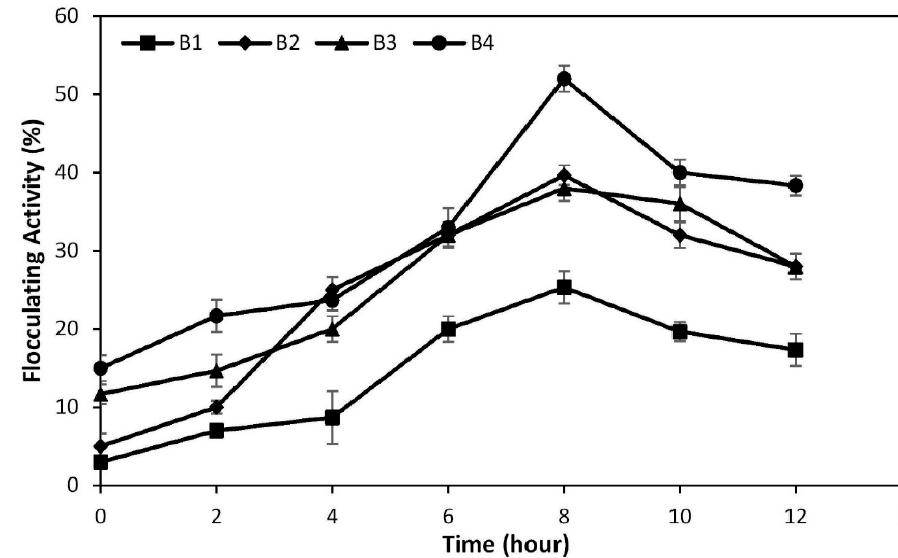
Figure 2. The flocculating activity of bioflocculant from Pseudomonas alcaliphila (B1), Pseudomonas oleovorans subsp. Lubricantis (B2), Pseudomonas chengduensis (B3), and Bacillus nitratireducens (B4) towards kaolin clay suspension. Experiment composition: 180 mL of kaolin suspension (5 g / L), 2 mL of culture broth containing the corresponding bacterial strain (B1, B2, B3, or B4), and 20 mL of CaCl 2 solution (10 g / L).